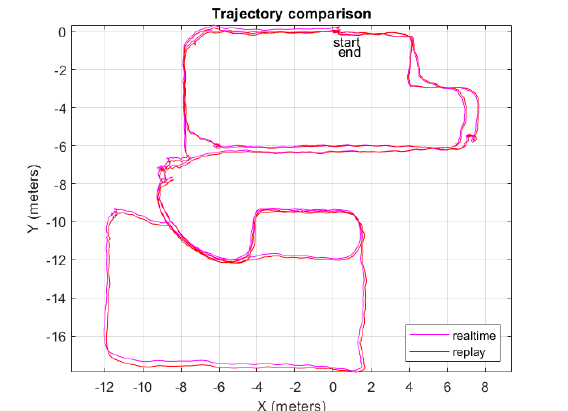
Figure 7. The top-view trajectory estimation comparison between real-time and replay solutions.